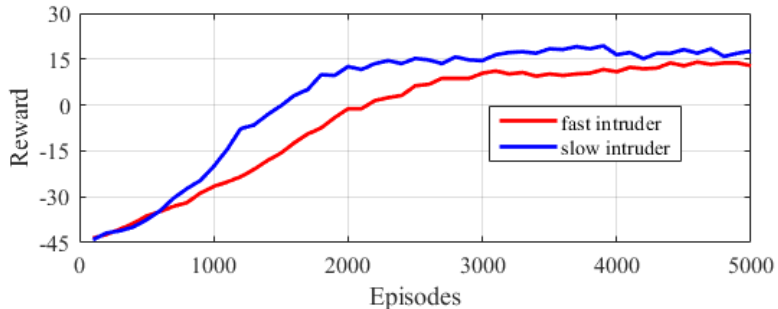
Figure 8. Average episode rewards for five USVs and one intruder.